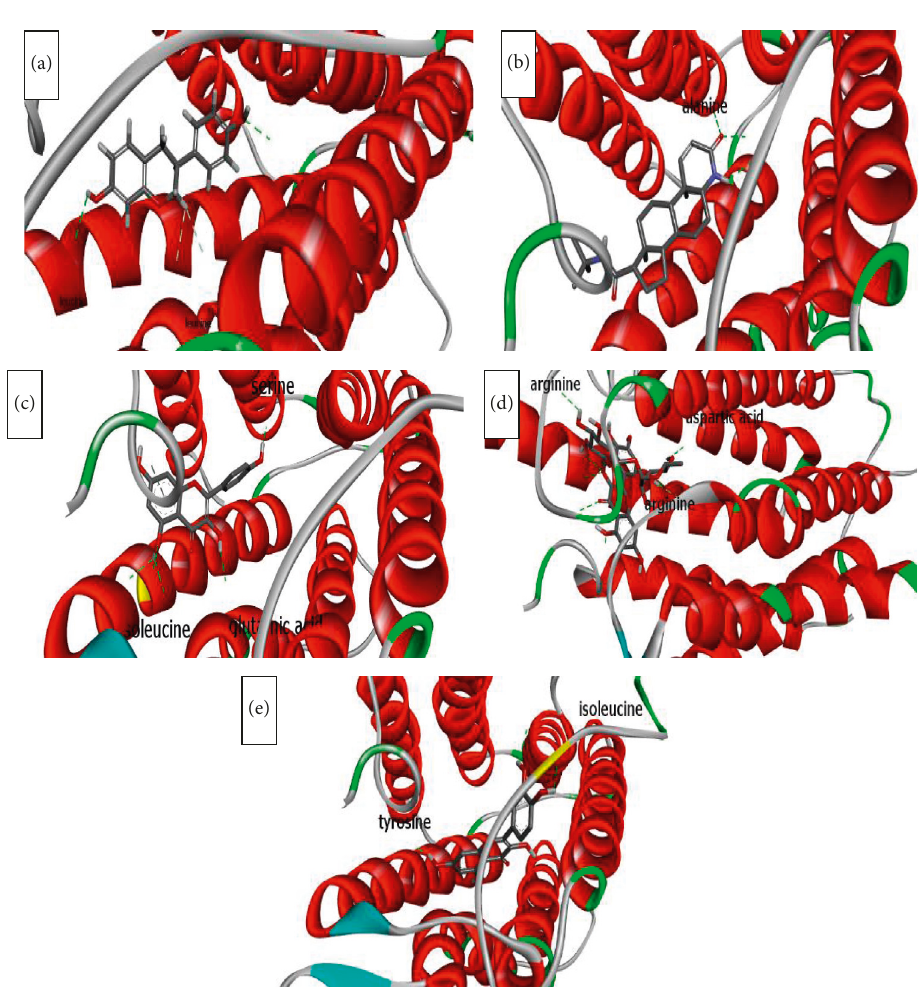
Figure 6: Interaction between amino acids in the binding site of 5 α -reductase enzyme, and (a) � equol, (b) � finasteride, (c) � kaempferol, (d) � quercetin, and (e) � rutin, respectively. The green bonds show intramolecular hydrogen bonds. Arginine, aspartic acid, alanine, glutamic acid, tyrosine, isoleucine, alanine, and serine are involved in H-bond interaction between ligands and